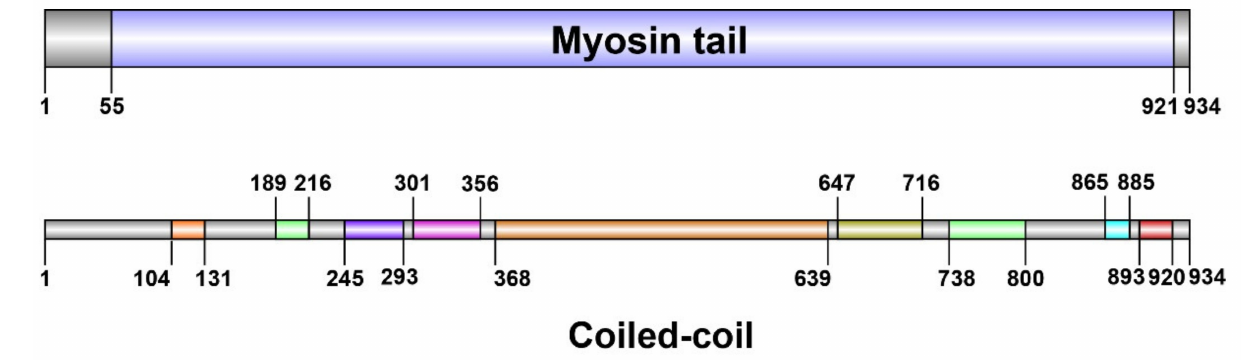
Figure 2. The functional domain and coiled-coil regions predicted by HMMER. For phosphorylation sites, there were a total of 96 positive predictions (32 known kinases and 64 non-specific prediction of kinase) at the threshold of 0.5 using NetPhos-3.1 (Figure 3). The most frequent phosphorylation type was Serine (S), which was located in 61 different positions, followed by 25 Threonine (T) and 10 Tyrosine (Y). Among these 32 known kinases, PKC (protein kinase C) was found to have the highest frequency of occurrence (18/32), especially at the N-terminus and C-terminus (Table 2). The other types of phosphorylation sites were also found in the paramyosin protein, including four cdc2, three PKA (protein kinase A), three CKII (casein kinase II), two DNAPK (DNA Protein Kinase), and two EGFR (Epidermal growth factor receptor).